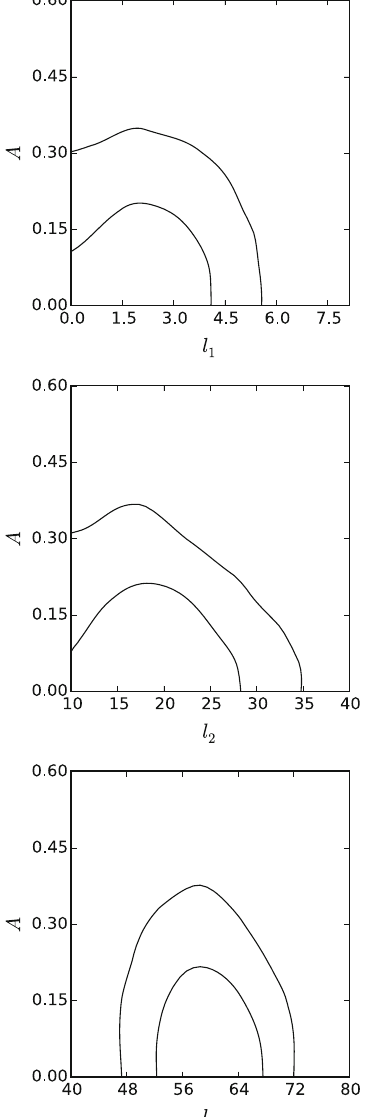
Fig. 4 Contours for the 68% and 95% confidence limits for the reso- nance parameters A = p 1 , q 1 , r 1 and multipole (cid:2) 1 , 2 , 3 ≡ p 2 , q 2 , r 2 for the three dips in the CMB power spectrum